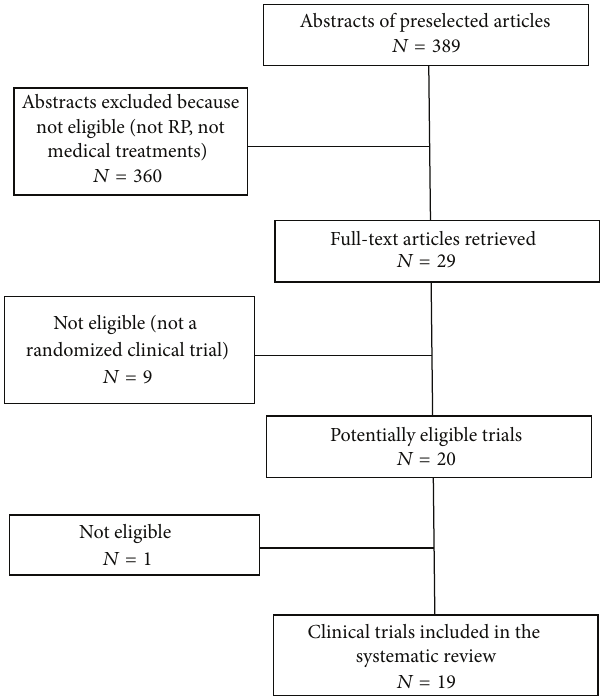
Figure 1: Decision tree of randomized clinical trials’ selection for inclusion in the systematic review and